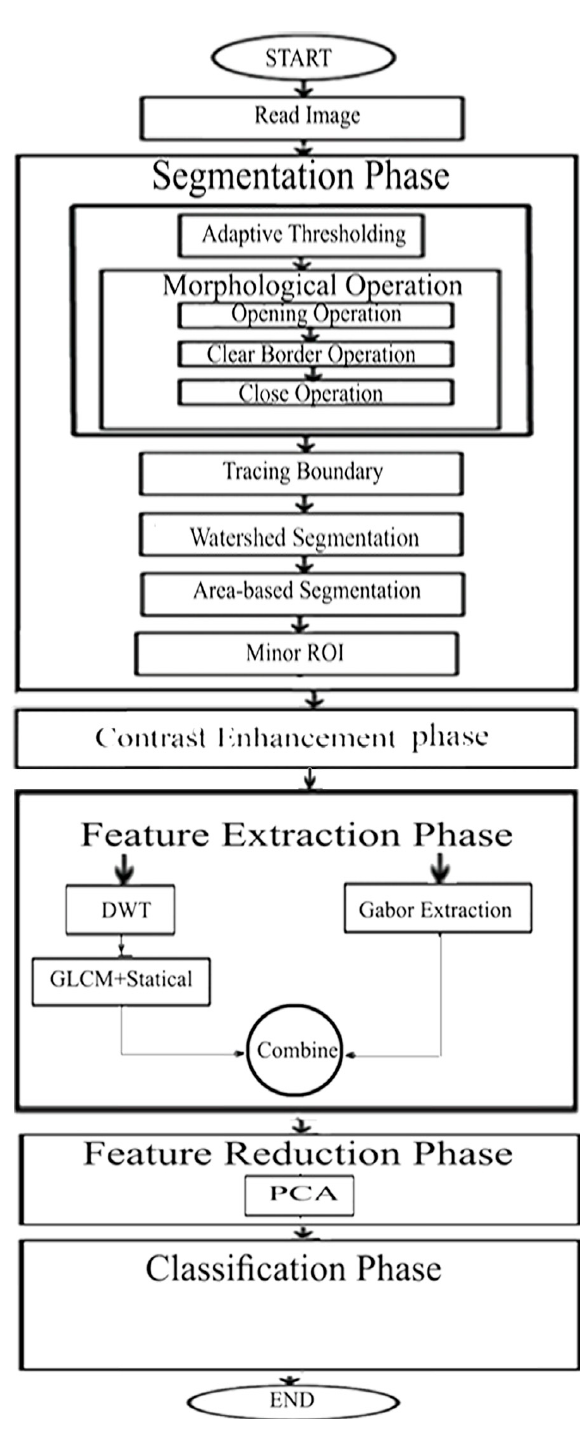
Figure 2. A diagram describing different phases of our novel approach.